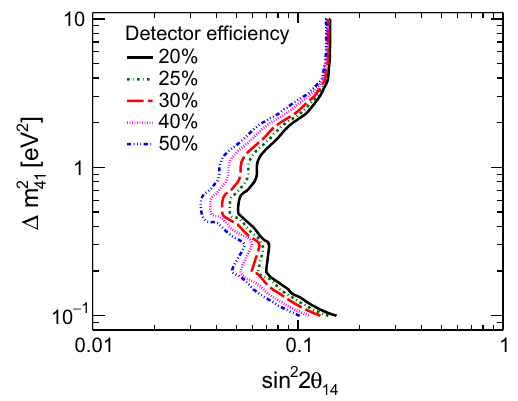
− sin 2 2 θ 14 plane, 41 ( 1 − U ) 2 , expected from 1ton-yr of the data e 4 e 4